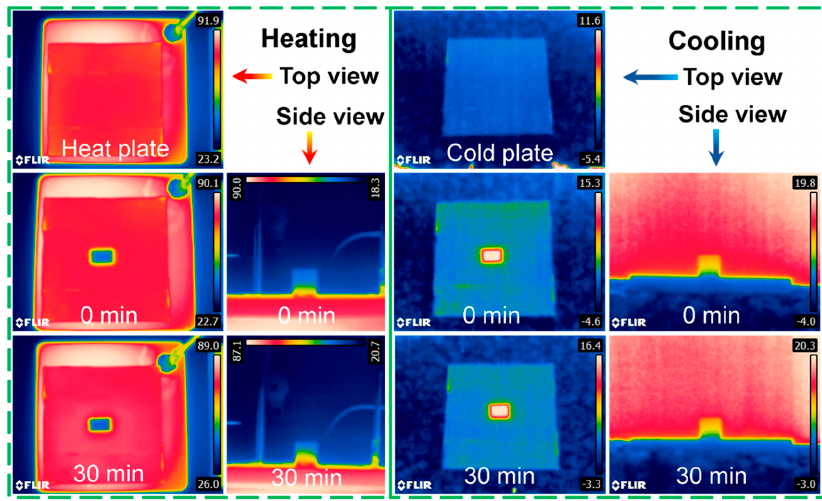
Figure 8. Infrared images of wood aerogel-8 h during the 30 min heating and cooling processes.